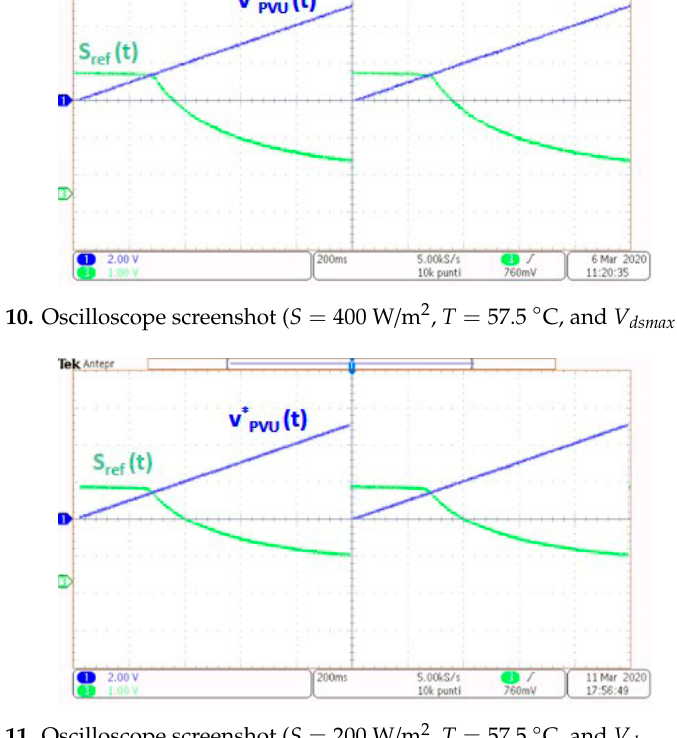
Figure 12. Oscilloscope screenshot ( 𝑆 = 400 W/m 2 , 𝑇 = 57.5 °C , and 𝑉 (cid:3031)(cid:3046)(cid:3040)(cid:3028)(cid:3051) = 50 V). Power block: The power block consists of two commercial power supplies BOP 100-4 [46], provided by Kepco (Flushing, New York, USA). One represents the power stage of the Boost based PV emulator and is used as a current- or voltage-controlled source. The other one is used as a controlled load in order to scan the I-V characteristics of the emulator. The two power supplies can work in all four quadrants of the current–voltage plane. They are linear power supplies with two bipolar control channels (voltage or current mode), selectable and individually controllable by either front panel controls or remote signals. In Table 2, the electrical characteristics of the proposed Boost based PVU emulator are reported. Table 2. Electrical characteristics of the proposed Boost based PVU emulator. Maximum output Current